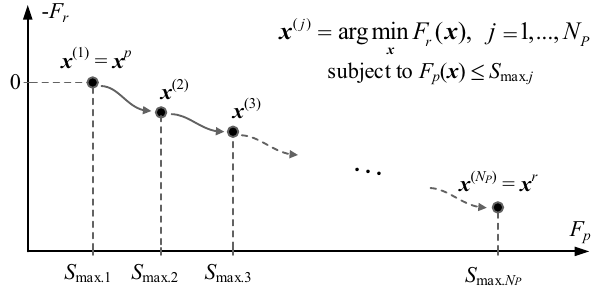
Figure 3. Graphical illustration of multi-criterial design with robustness evaluation. The graph visualizes successive rendition of performance-robustness trade-off solutions, starting from the best nominal design x p .